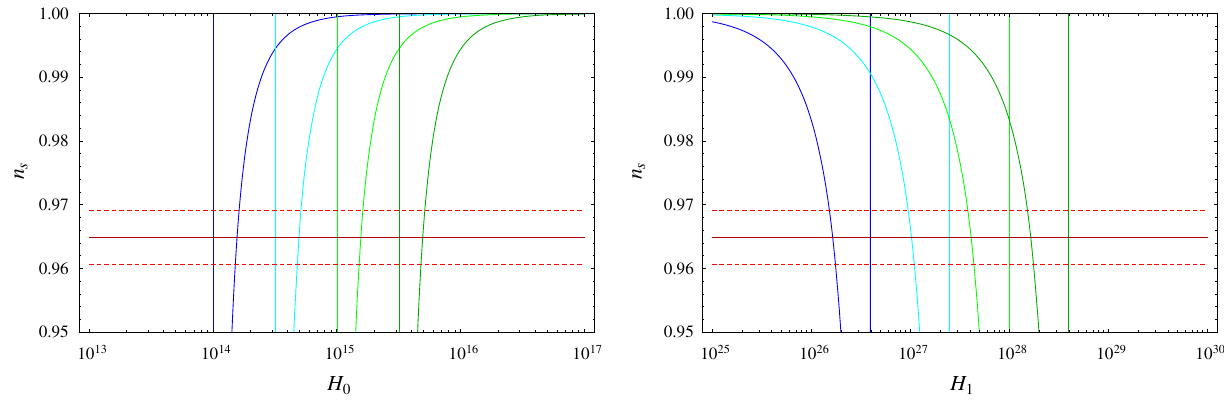
Fig. 5 The spectral index n S with respect to H 0 the left, and to H 1 in the right, for N = 50 and γ = b = 1 and μ = 1s − 1 . The plots are identical for N = 60 and any other values of γ , b and μ . The blue, cyan, green and darker green curves correspond to different values of H 1 and